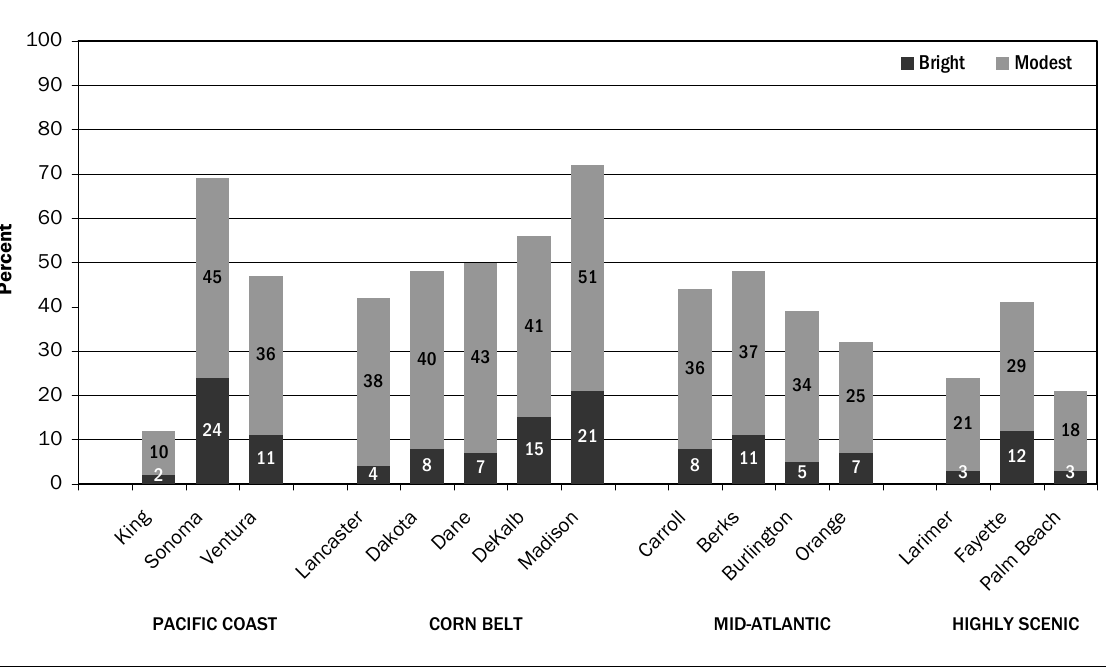
Figure 2. Percentage of Survey Respondents Reporting that Agriculture Has a “Bright” or “Modest” Future in the County in 20 Years, 2005